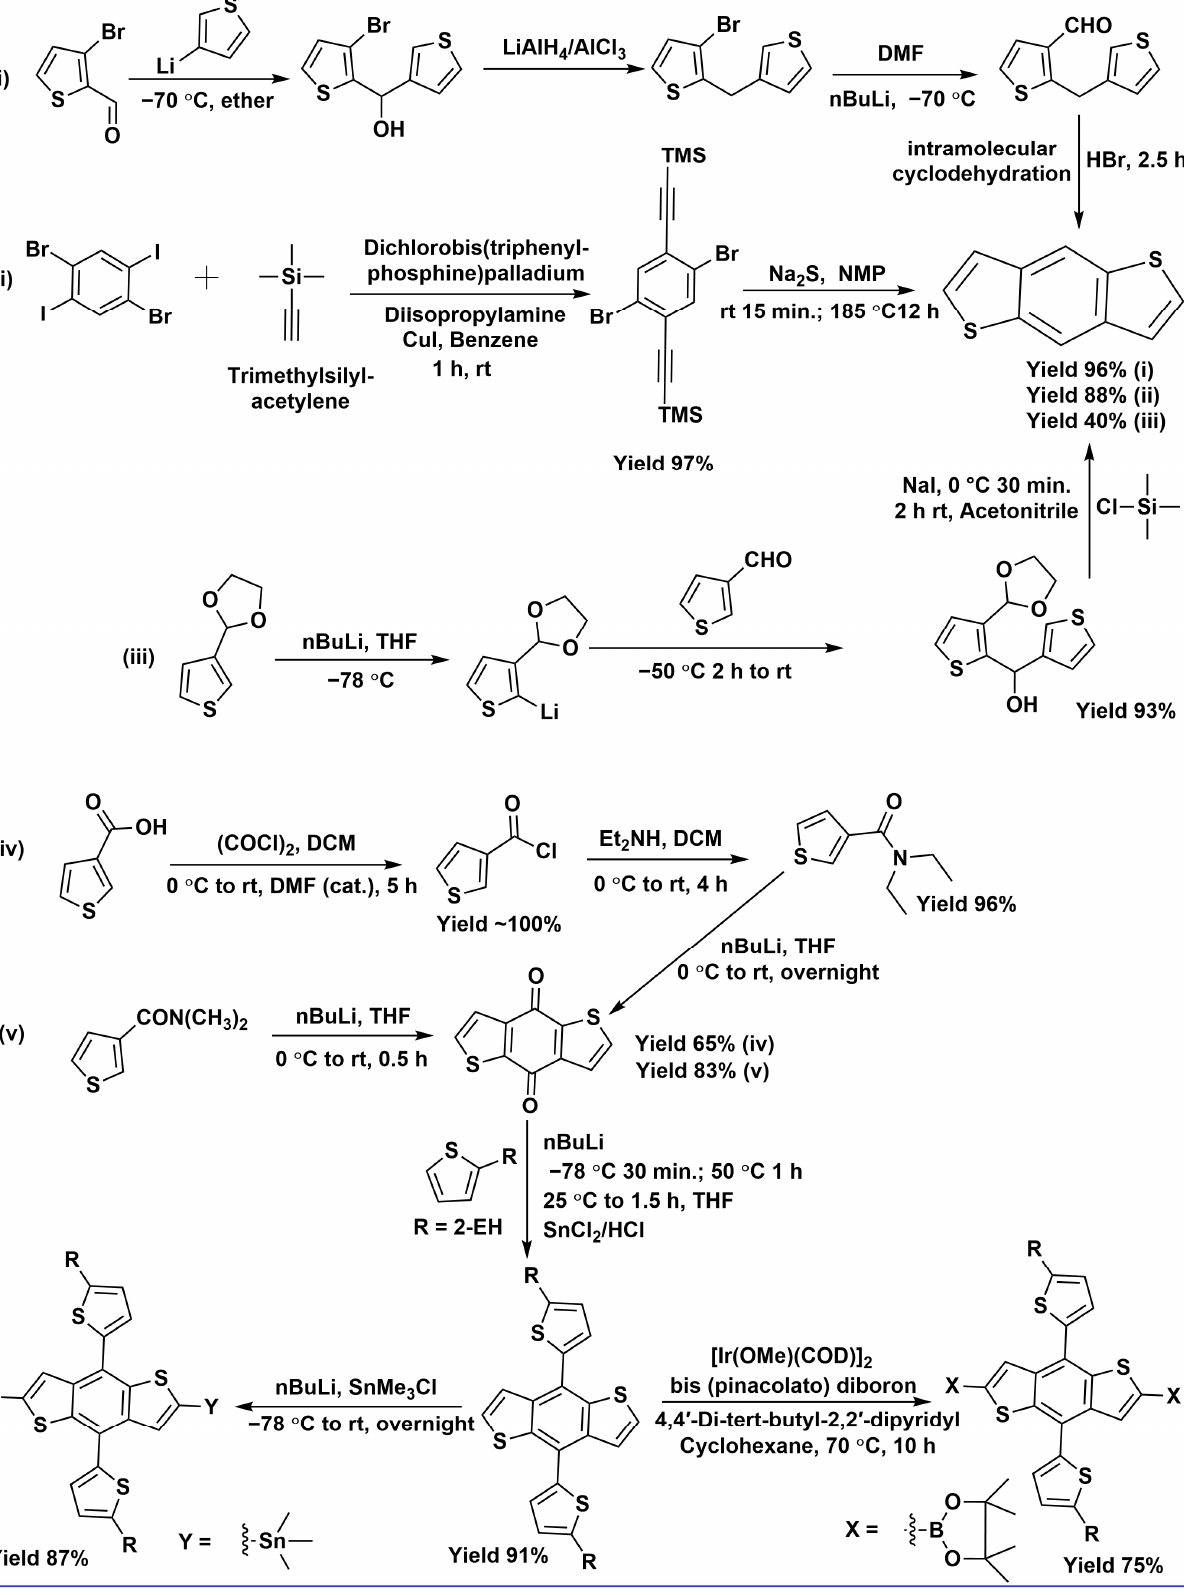
Figure 2. Common synthetic procedures for BDT monomer unit.